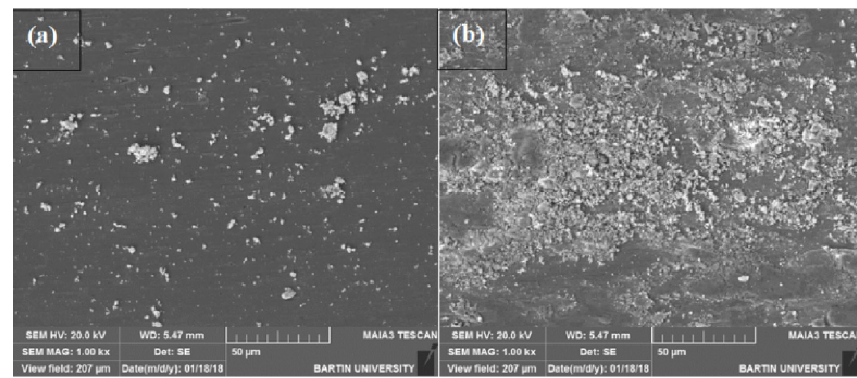
Fig. 12 SEM morphologies of the wear surface of the CoCrFeNiTi 0.5 Al alloy specimen at (a) 250 ° C and (b) 500 °